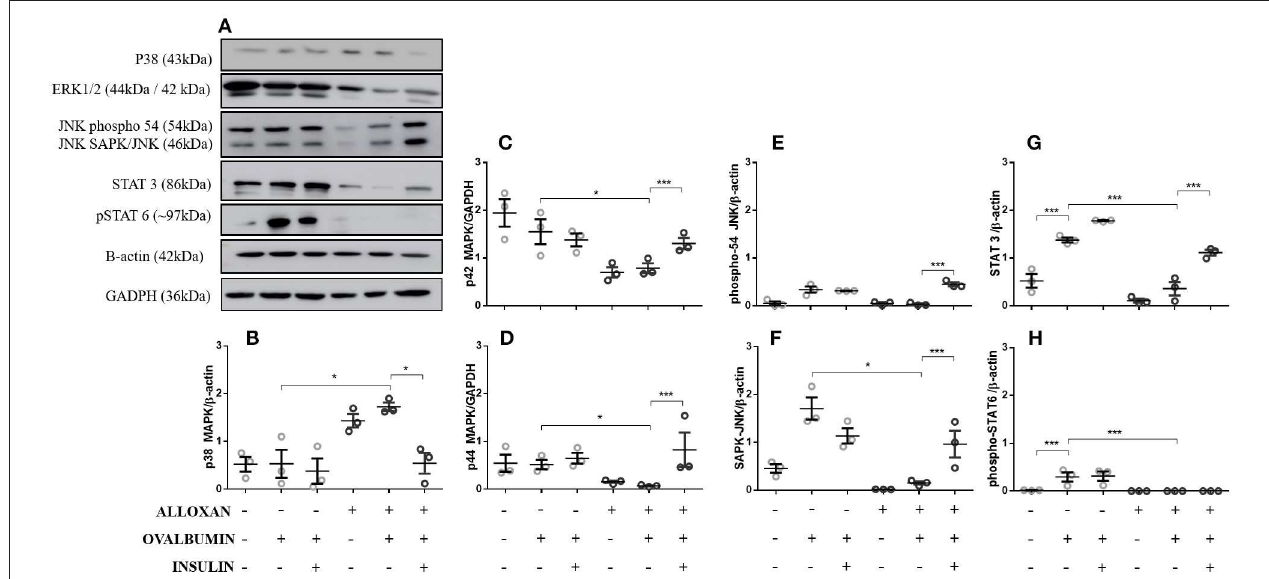
FIGURE 1 | Levels of signaling molecules in lung homogenates. After collection of the lung, a lung tissue homogenate was created with RIPA buffer. (A) p38 MAP kinase (Thr180/Tyr182), ERK1/2 MAP kinase (Thr183/Tyr185), JNK (phospho-54/SAPK-JNK), STAT-3 (124H6), phospho-STAT 6 (Tyr641), β -actin protein and GAPDH levels in lungs from diabetic and non-diabetic mice subjected to an OVA challenge were determined by Western blotting. Relative (B) p38 MAP kinase; (C) ERK 1 (p42 MAPK); (D) ERK2 (p44 MAPK); (E) JNK (phosphor-54); (F) JNK (SAPK/JNK); (G) STAT3; and (H) Phospho-STAT6. Values represent the mean ± SEM from three independent experiments ( n = 3 per group). * p < 0.05; *** p < 0.001. The groups were tested with two-way analysis of variance followed by Tukey-Kramer post-hoc tests (GraphPad Prism version 6.0 for Windows, GraphPad Software, La Jolla, CA, USA).